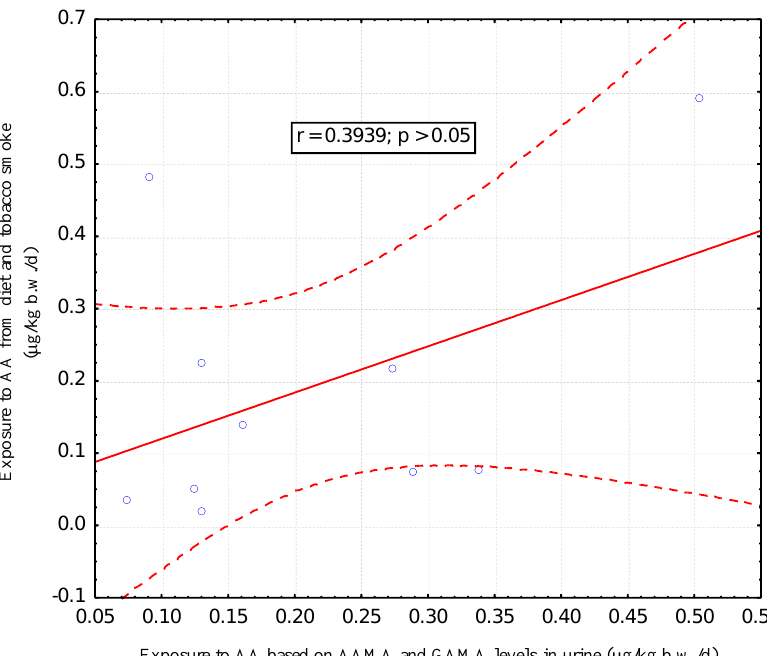
Figure 3. Correlation between exposure to acrylamide estimated based on a 24-h dietary recall after childbirth and passive smoking during pregnancy and AAMA and GAMA levels in urine after childbirth in the group of passive smokers ( n = 10).